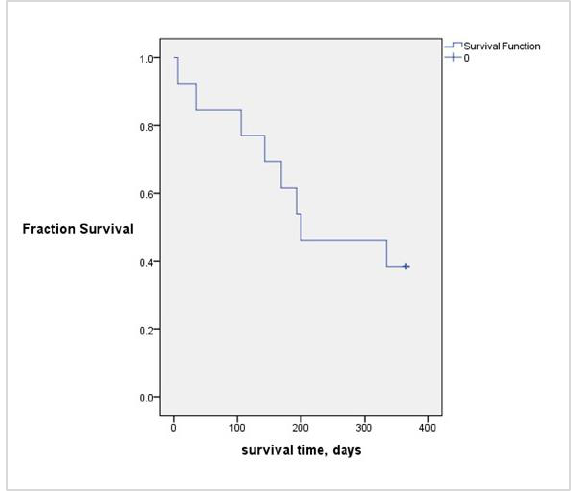
Figure 2: Kaplan-Meier plot of survival time. Seven of 12 pa- tients (58%) died within the 12 months of follow-up. Median survival time was 207 days (range 6–365). Table 2: Clinical outcome indicators. ECP After ECP p-value Median FEV1 (range), ml 920 (610–3660) 800 (520–3720) 0.003 Median FEV1 decline per 13 (8–110) 17 (6–163) month (range), ml